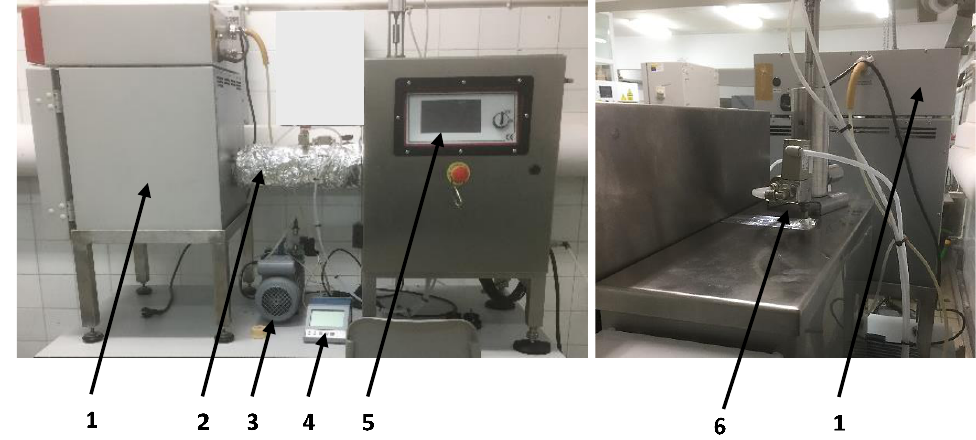
Figure 2. EO vaporization device at the pilot plant scale based on the “surface decontamination of solid food with vapor EOs under vacuum conditions” (SDuVC) technology. The numbers refer to: (1) vacuum camera, (2) isolated tube, (3) vacuum pump, (4) vacuum control system, (5) control panel and (6) evaporator unit. (Reprinted from “Fresh culinary herbs decontamination with essential oil vapors applied under vacuum conditions”, 156, 110942, López-Gómez et al., Copyright (2019), with permission from Elsevier.).